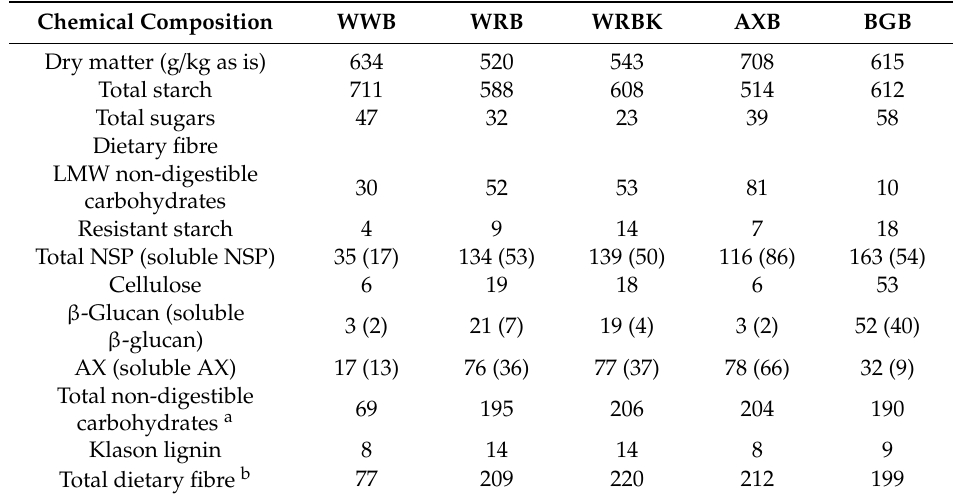
Chemical composition (g / kg dry matter (DM)) of the experimental test breads, see Christensen et al. [18] for